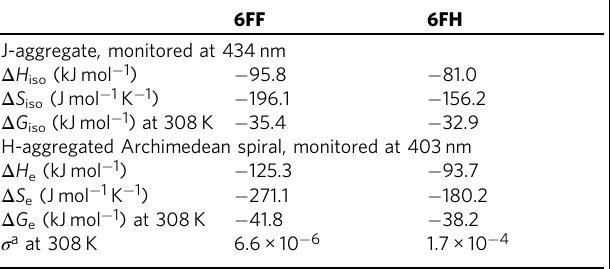
Table 1 Thermodynamic parameters.